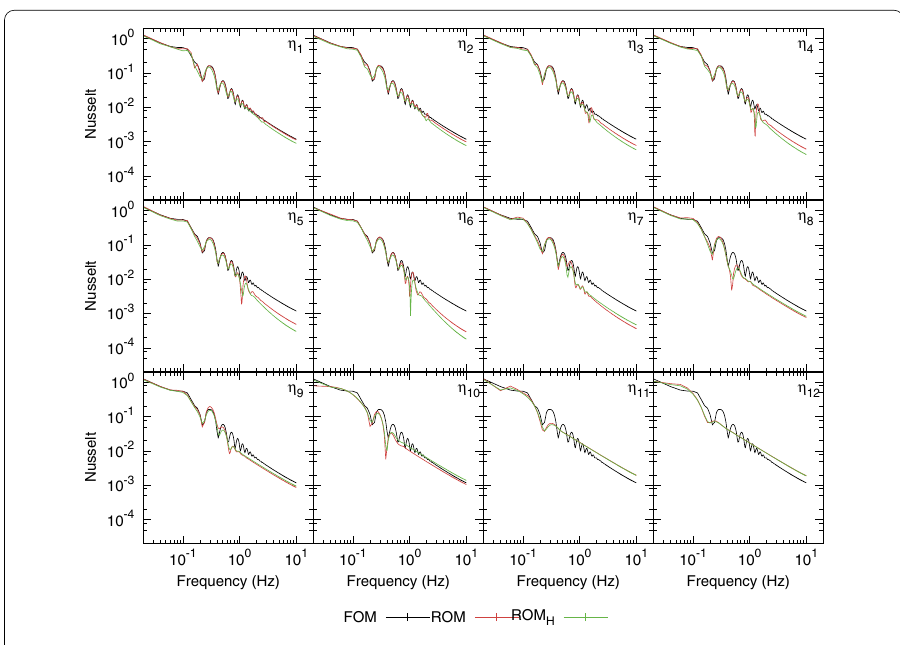
Fig. 8 Fourier transform of the Nusselt number for the hot wall